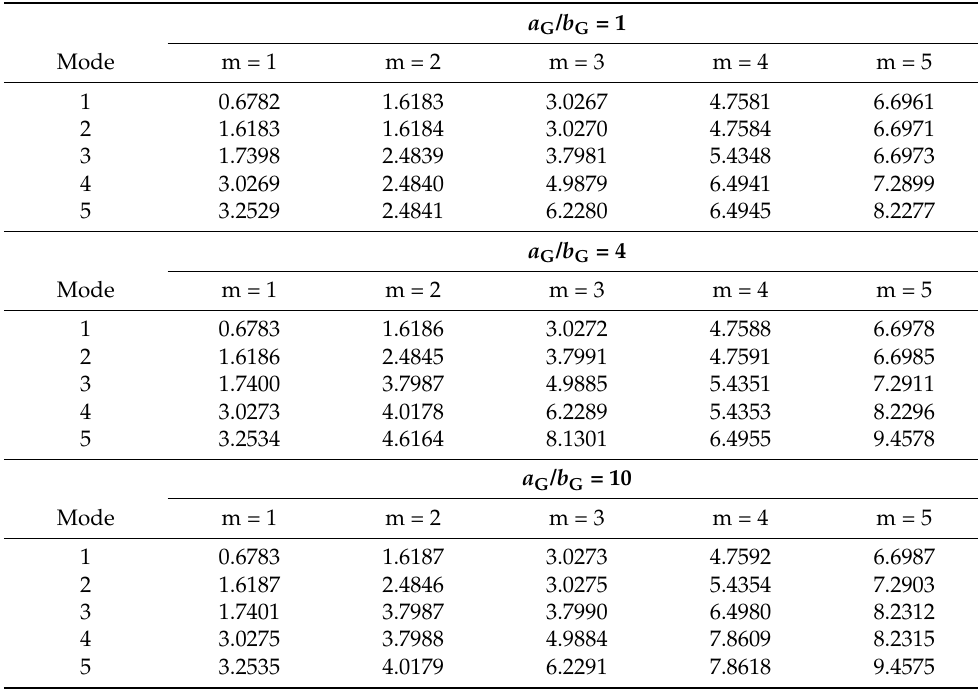
Table 3. Natural frequencies of the SSSS GPLs reinforced PMMA square plates for different GPLs aspect ratios ( b G = 1.5 µ m).